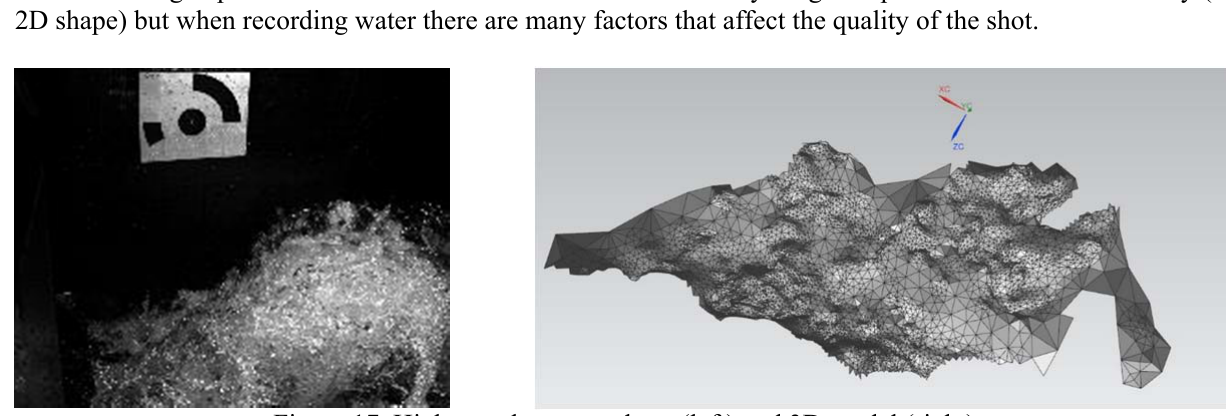
Figure 17. High speed camera photo (left) and 3D model